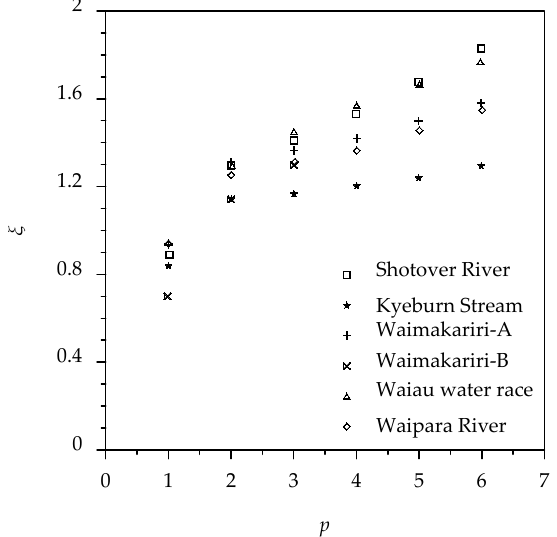
Figure 5. Variations of scaling exponents ξ of the generalized structure function with the order p (data extracted from Nikora and Walsh [17]).